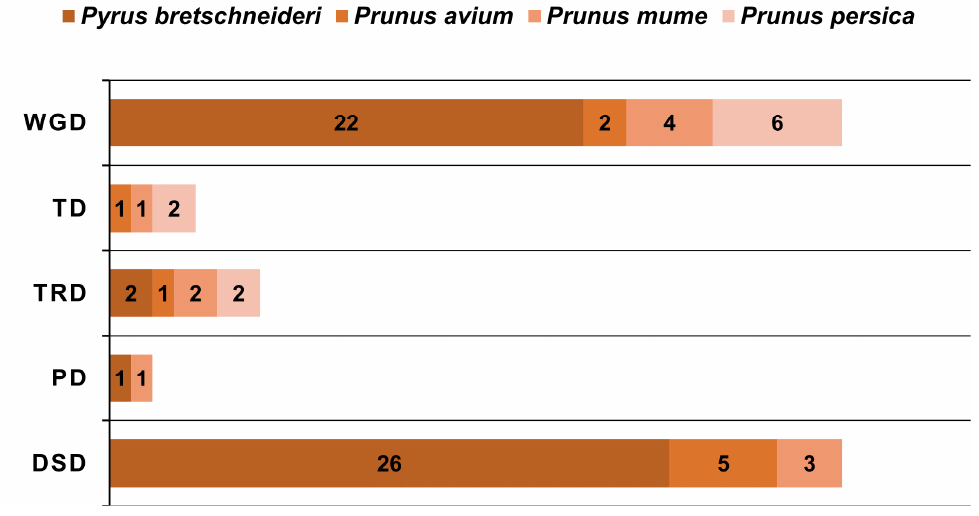
Figure 4. Mode and the total number of gene duplications (DSD, dispersed duplicates; PD, proximal duplicates; WGD, whole-genome duplicates; TRD, transposed duplicates; TD, tandem duplicates) of GATA gene family in Rosaceae species. Different bars indicate the duplicated gene pairs, and each color represents each species.